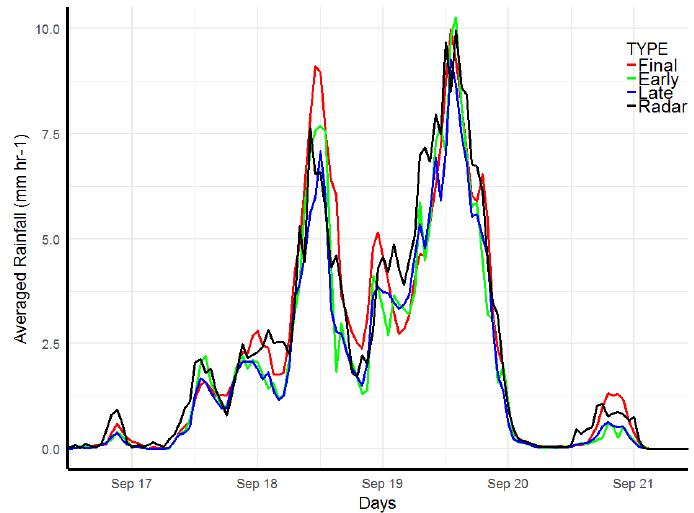
Figure 4. Time series plot of areal average precipitation estimates captured by the IMERG and Stage-IV products during Tropical Storm Imelda (17–21 September 2019).